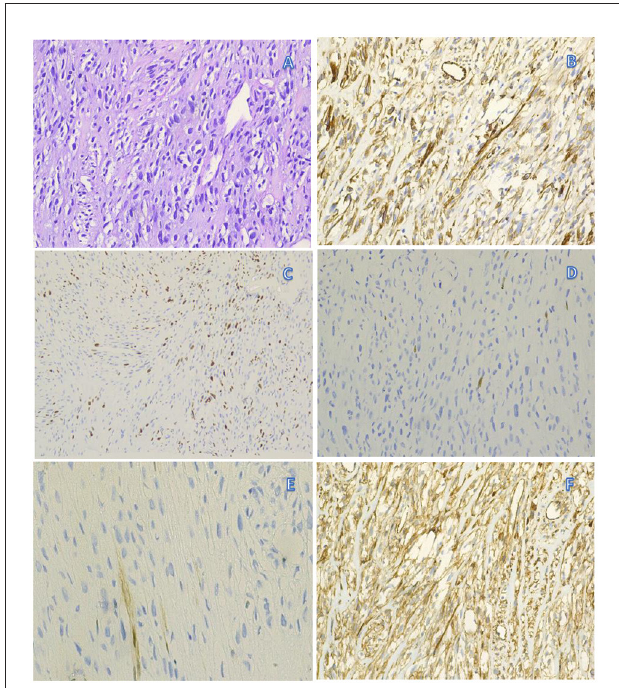
FIGURE4 Pathology (tissue of brachial plexus swelling in the left supraclavicular fossa): diffuse lamellar arrangement of the spindle or oval cells, mild-moderate heterogeneity of the nuclei, nuclear schism 4/10HPF, some interstitial vitreous changes, chondrogenic differentiation visible in focal areas (A) . Immunohistochemistry: Vimentin ( + ) (B) , Ki-67 (25% + ) (C) , SOX10 (individual cells + ) (D) , S-100 (individual cells weakly + ) (E) , P120 ( + ) (F) . In summary, a diagnosis of malignant peripheral schwannoma was